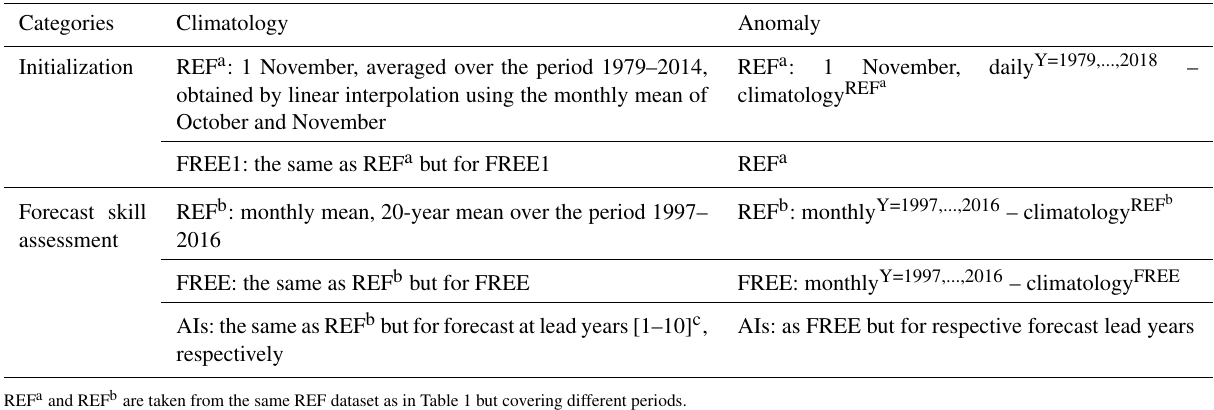
Table 2. Definitions of initial/forecast climatologies and